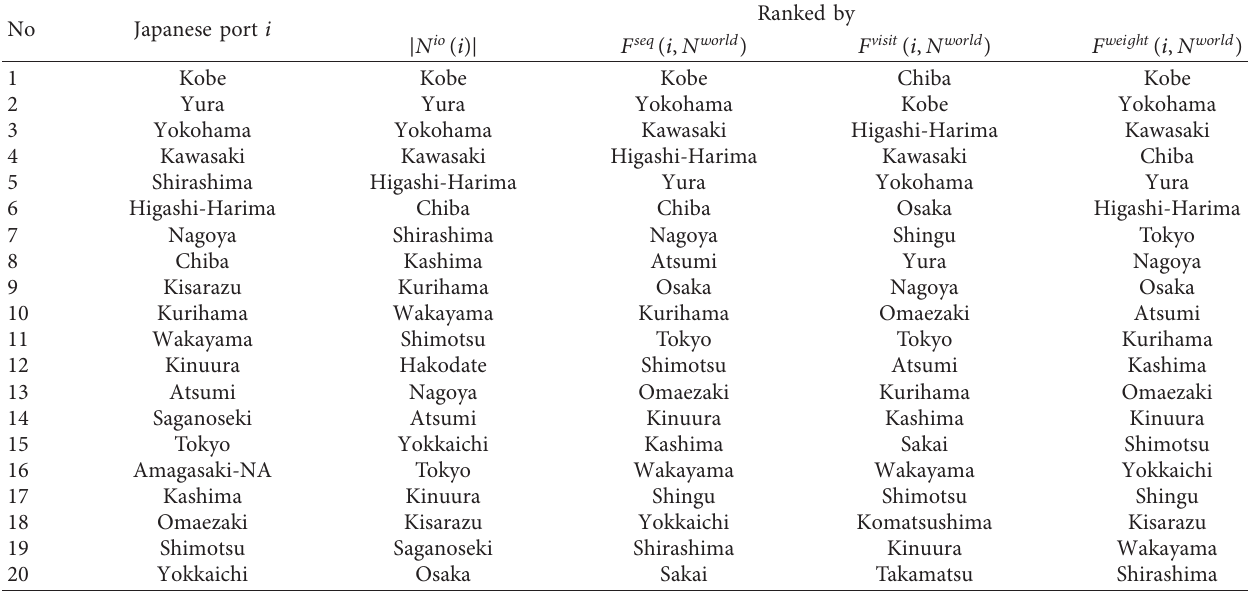
Table 7: Ranking Japanese ports by trading-related values.